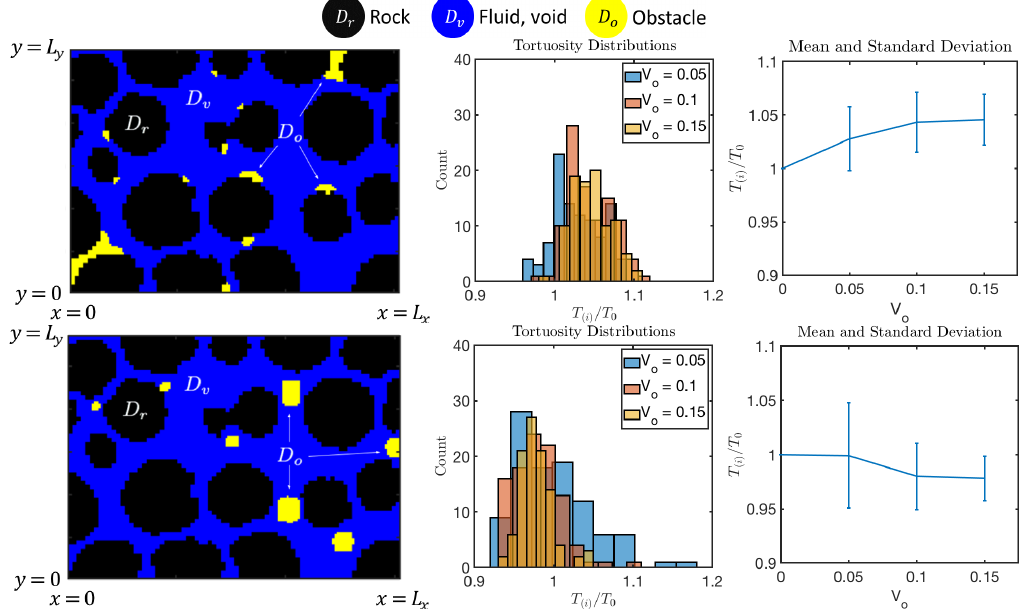
Figure 27. Transport properties with geometries D o created by CLPS in Example 4. Top row: pore-coating, and bottom row: pore-filling geometries. Left: example of D o with V o = 0.05. Middle and right: experimental probability distribution of relative change in tortuosity ( T ( i ) / T 0 ) i for three values of V o